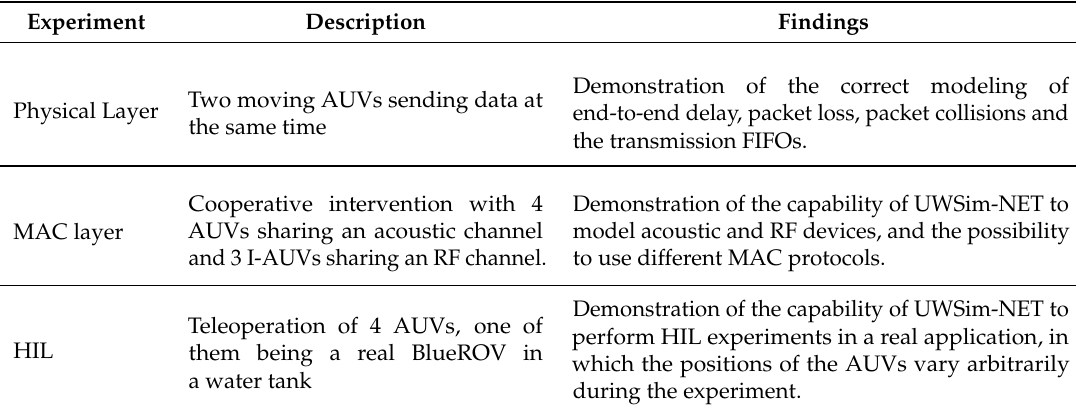
Table 2. Summary of the main findings of each